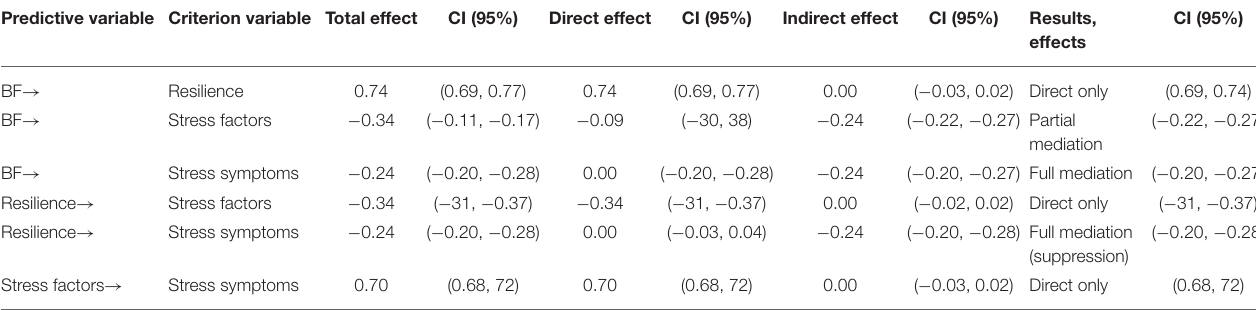
TABLE 9 | Total, indirect, and direct effects of the variables in this study, and 95% bootstrap confidence intervals (CI). Predictive variable Criterion variable Total effect